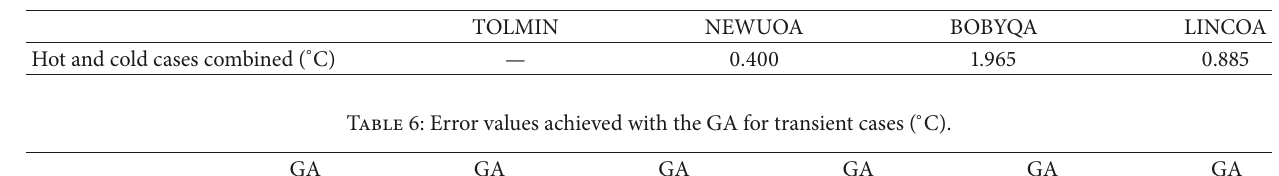
Table 5: Error values achieved with Powell’s algorithms for transient cases ( ∘ C).